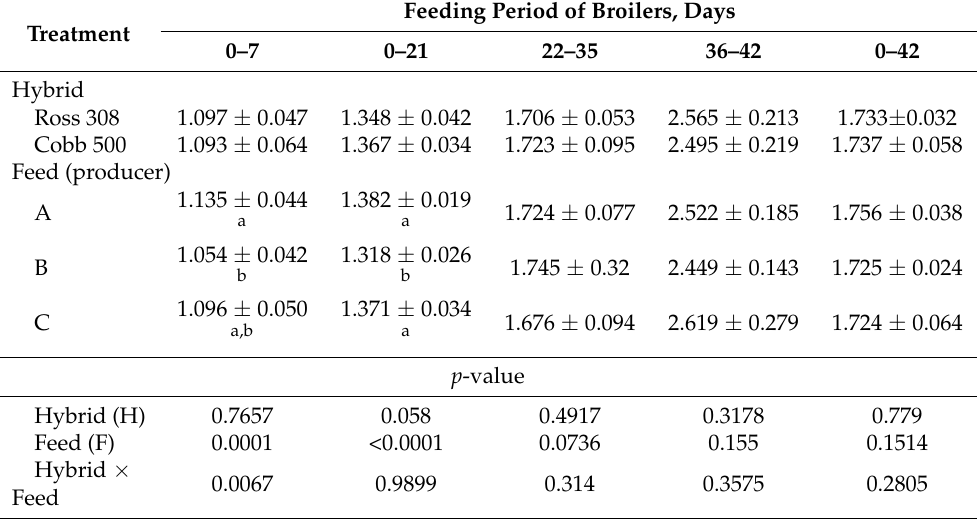
Table 5. Feed conversion ratio (FCR) in test of feeding different hybrids with different market feeds (mean ± standard deviation), kg feed/kg weight